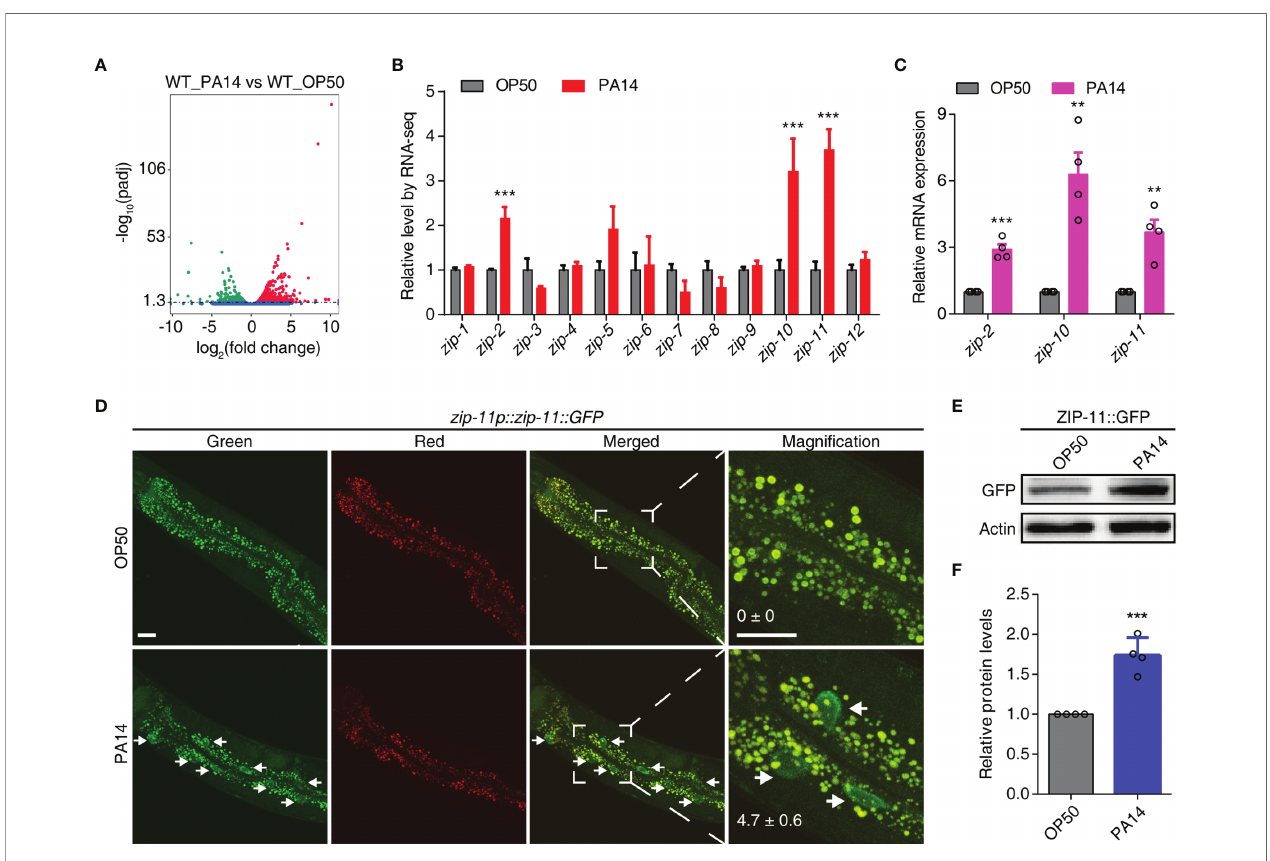
FIGURE 1 | P. aeruginosa PA14 infection induces the expression of ZIP-11. (A) Volcano plot of RNA-seq showing different regulated genes (up-regulated genes in red; down-regulated genes in green; no signi fi cantly-changed genes in blue) of wild type worms upon P. aeruginosa PA14 infection. (B) Quanti fi cation of RNA-seq reads indicating up-regulation of zip-2 , zip-10 and zip-11 but not the other members of the zip class genes. (C) qRT-PCR analysis of zip-2 , zip-10 and zip-11 gene expression in WT worms exposed to E. coli OP50 or P. aeruginosa PA14. (D) Representative images of the zip-11p::zip-11::GFP worms exposed to E. coli OP50 or P. aeruginosa PA14. Right panels are higher magni fi cation. Mean percentages of ZIP-11::GFP nuclear accumulation in the anterior portion of intestinal tissue (white arrows) are indicated. n ≥ 14. Scale bar: 20 m m. (E) Western blots of the zip-11p::zip-11::GFP worms exposed to E. coli OP50 or P. aeruginosa PA14 by using anti- GFP antibody. (F) Quanti fi cation of the protein expression levels using the software program ImageJ. Data are presented as mean ± SEM. Statistical signi fi cance was determined by Student ’ s t -test (C, F) . **p < 0.01, ***p < 0.001 compared with respective controls unless speci fi cally